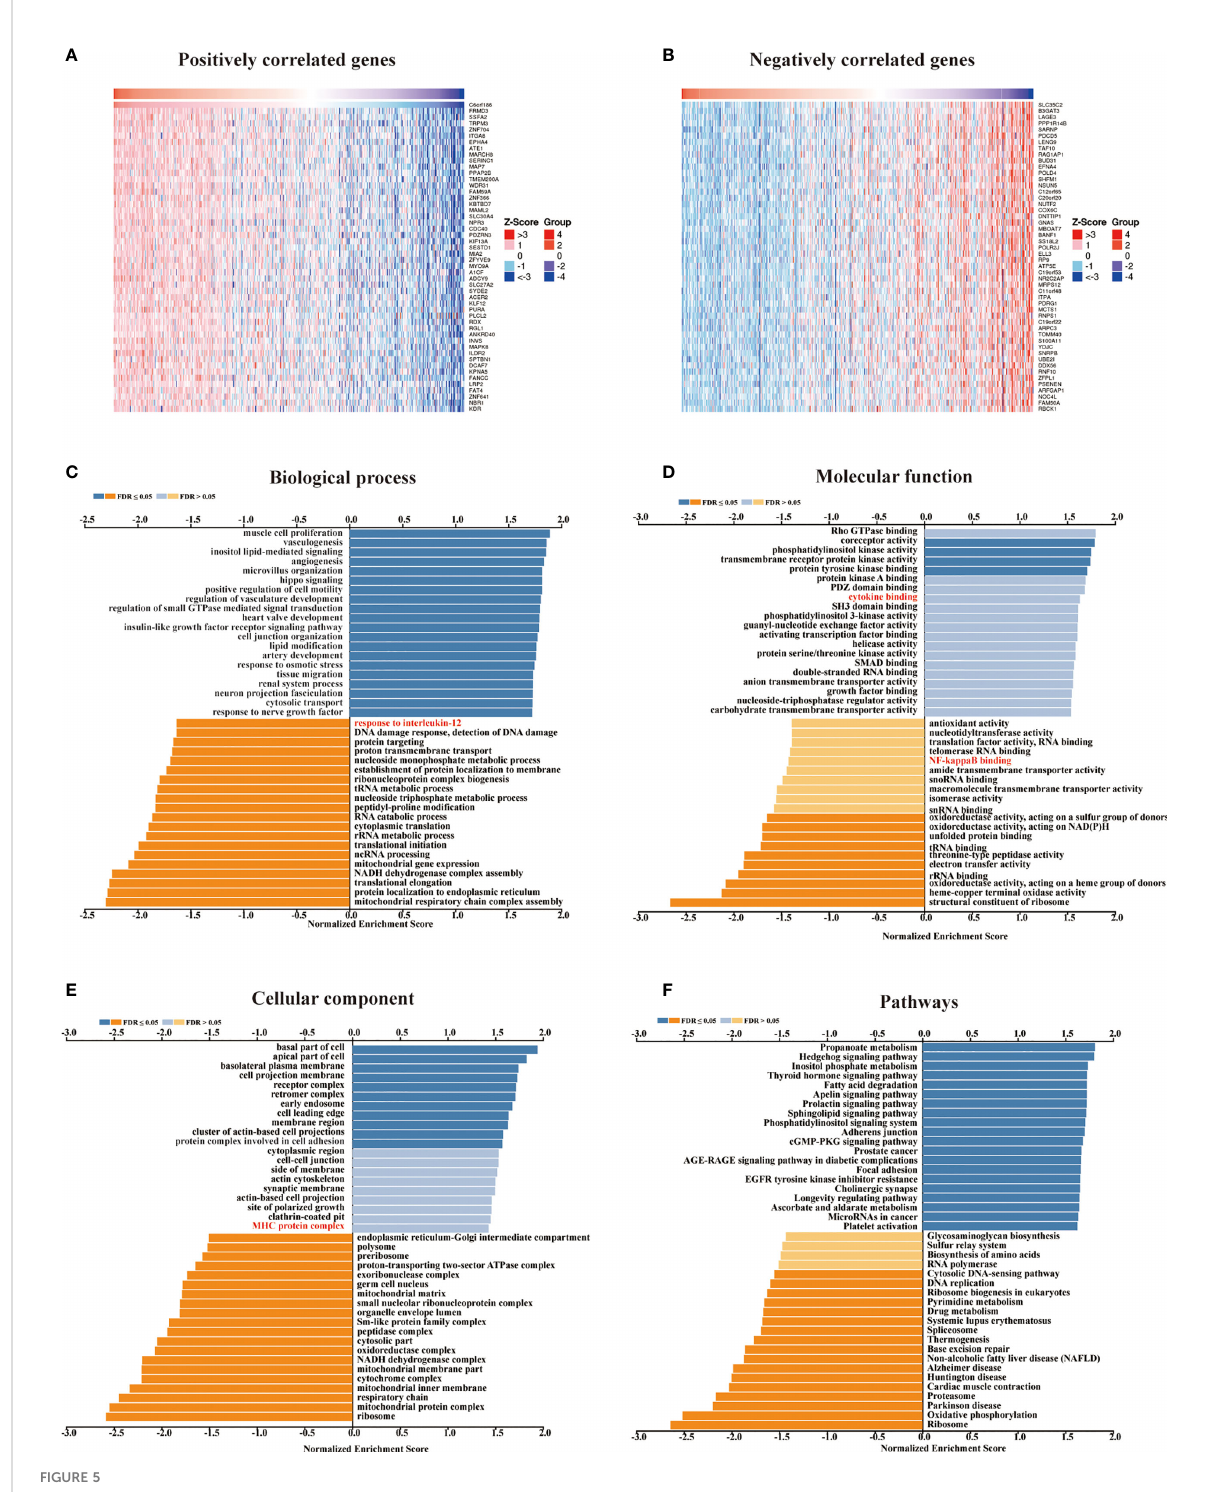
FIGURE 5 In KICR, METTL24 most likely served an immune function. (A, B) The heat maps showed the top 50 positively and negatively expression- correlated genes of METTL24. The METTL24 relevant (C) biological processes (BP), (D) molecular functions (MF), (E) cellular compartments (CC), (F) and pathways in